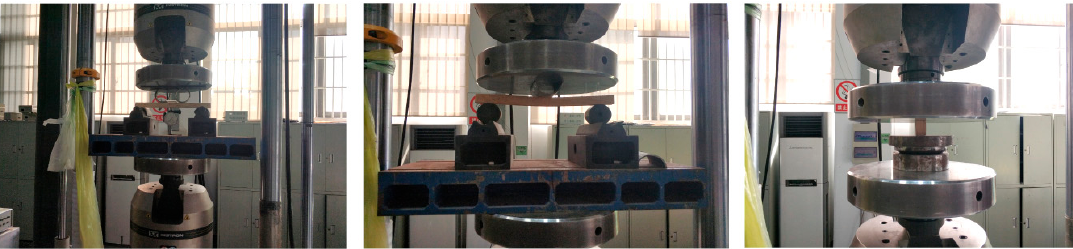
Figure 4. Material properties tests of Chinese fir. Table 2. Average material properties of the wood from own measurements.